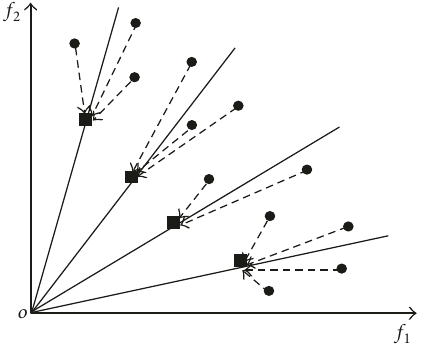
Figure 4: Finding the global best guide in two-objective space.